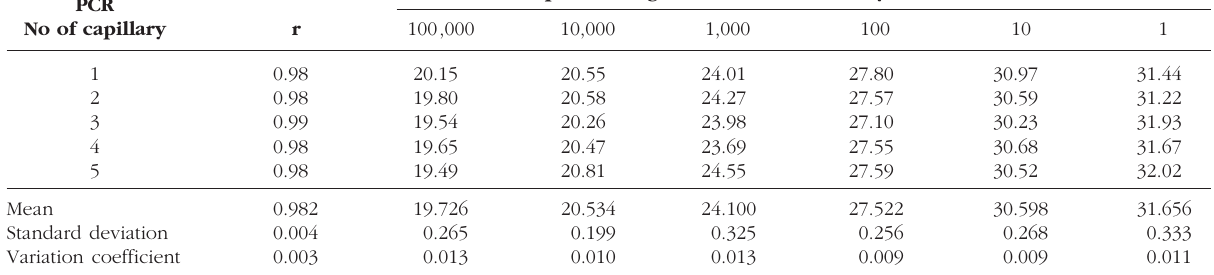
Table I. – Intra- and inter-assay reproducibility crossing point values for each point of the standard